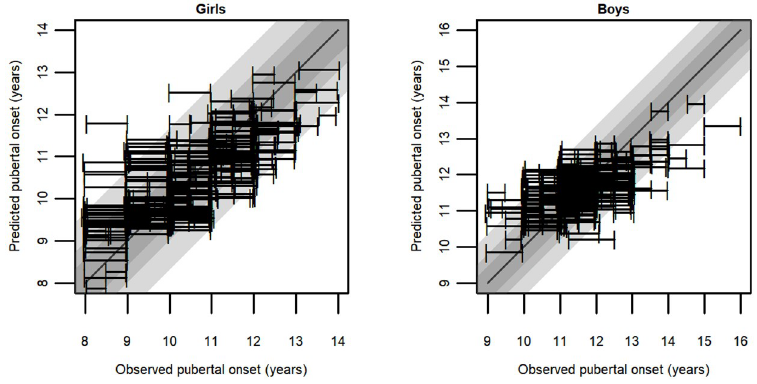
Fig 1. Observed pubertal onset intervals plotted against the predicted pubertal onsets for girls and boys. Grey areas represent 50%, 75% and 95% prediction